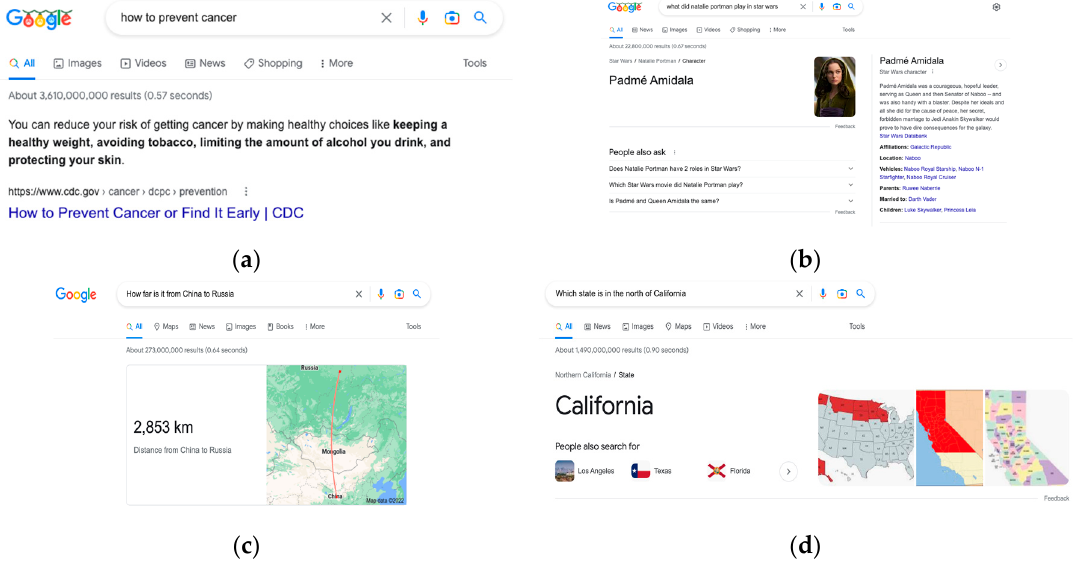
Figure 1. Open-domain QA examples. The questions in ( a , b ) are about general knowledge, and ( c , d ) are about geographic domains. ( a ) Example of TextQA regarding general knowledge; ( b ) example of KBQA regarding general knowledge. ( c , d ) Simple questions that Google QA fails regarding geographic domains: ( c ) distance between adjacent countries (answer should be 0 or adjacent); ( d ) question about cardinal direction. This case study demonstrates that even Google QA fails at simple geographic questions that require simple geographic domain knowledge.